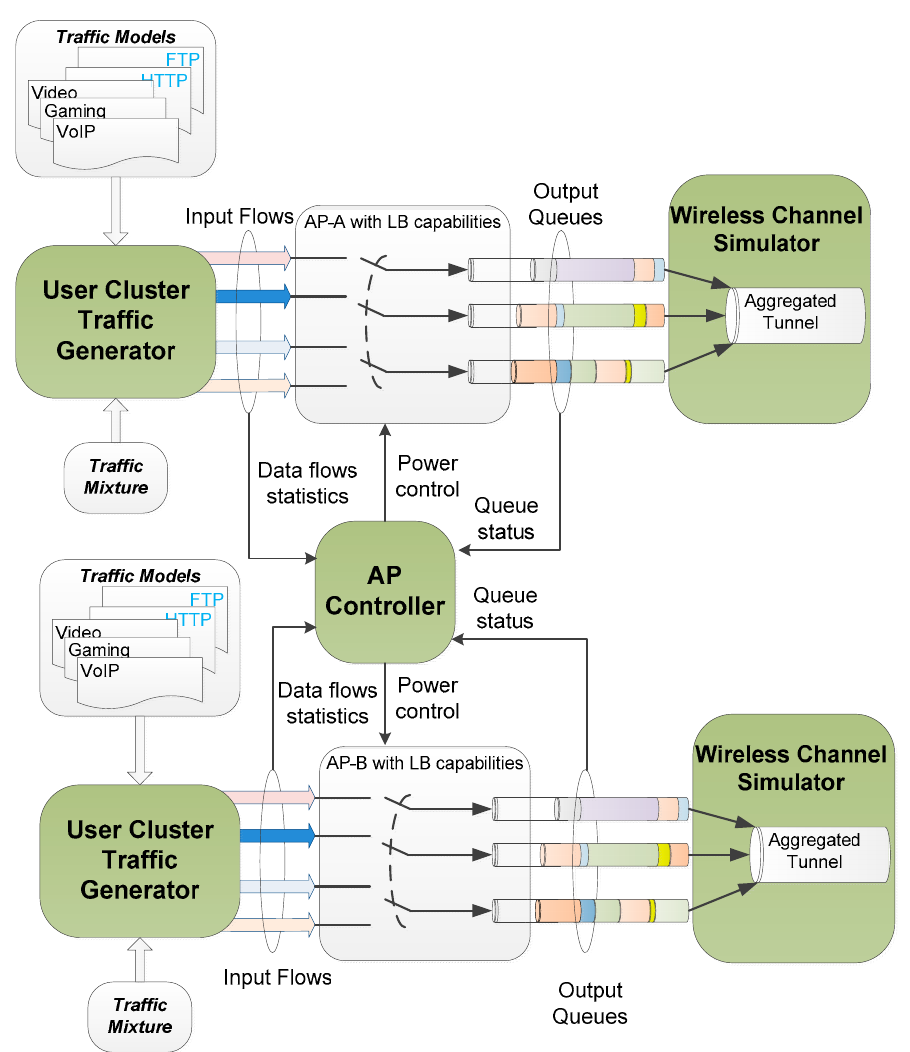
Figure 9. The block diagram of the simulation platform used for the evaluation of the user clustering algorithms.